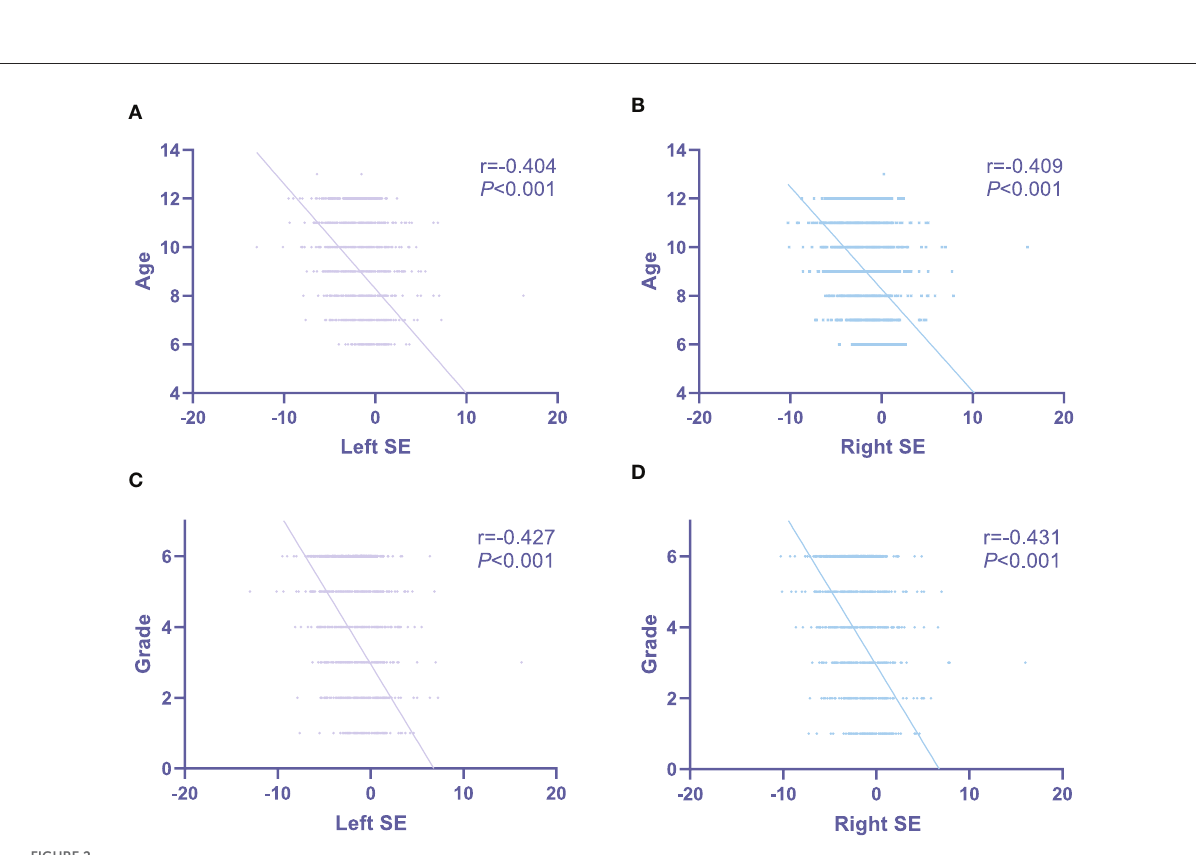
FIGURE2 The associations of bilateral spherical equivalent with age and grade in primary-school students in Xi’an. (A) The associations of left spherical equivalent with age; (B) the associations of right spherical equivalent with age; (C) the associations of left spherical equivalent with grade; (D) the associations of right spherical equivalent with grade. SE, spherical